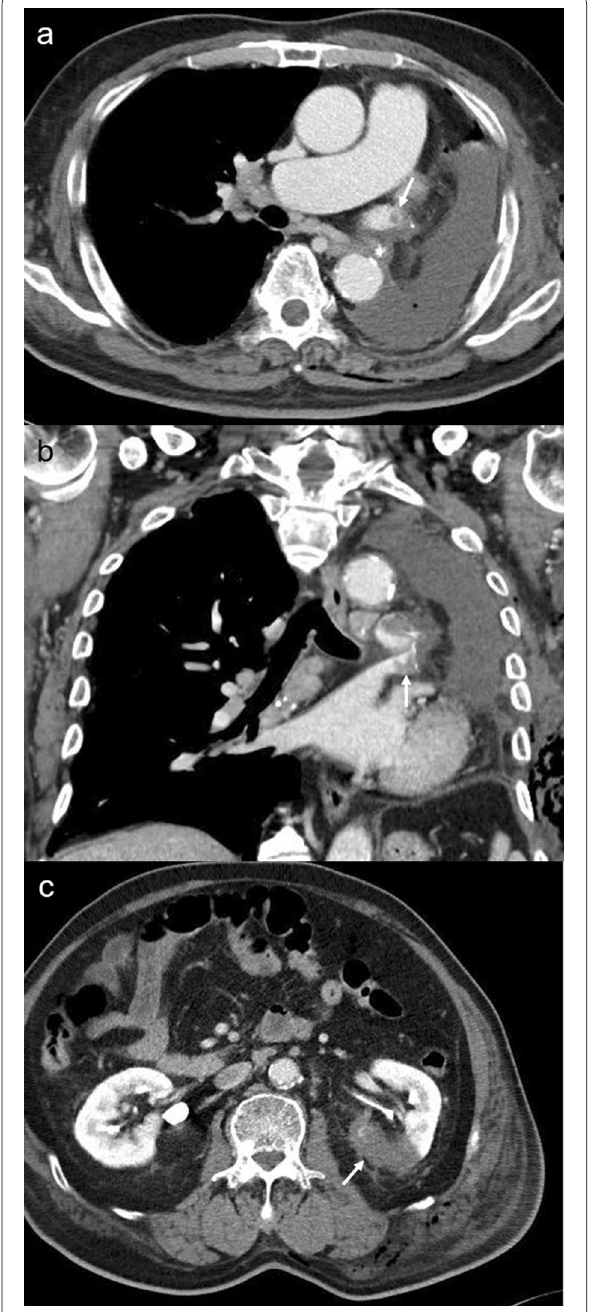
Fig. 2 Contrast-enhanced computed tomography reveals a thrombus in the left upper pulmonary vein stump: a coronal view, b horizontal view, and c partial defect of the left kidney on postoperative day 4